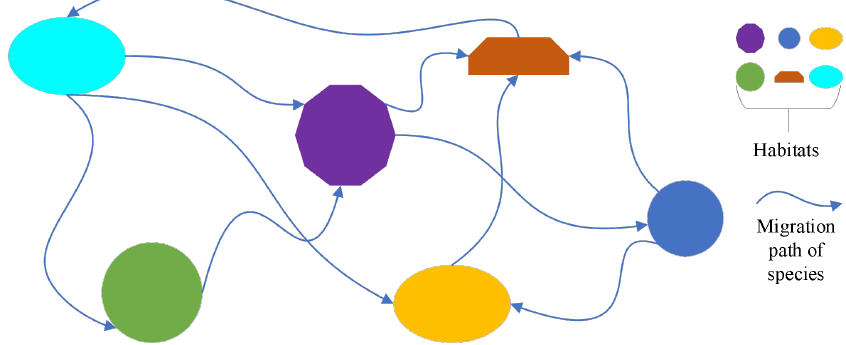
Figure 3. Diagram of BBO habitat and